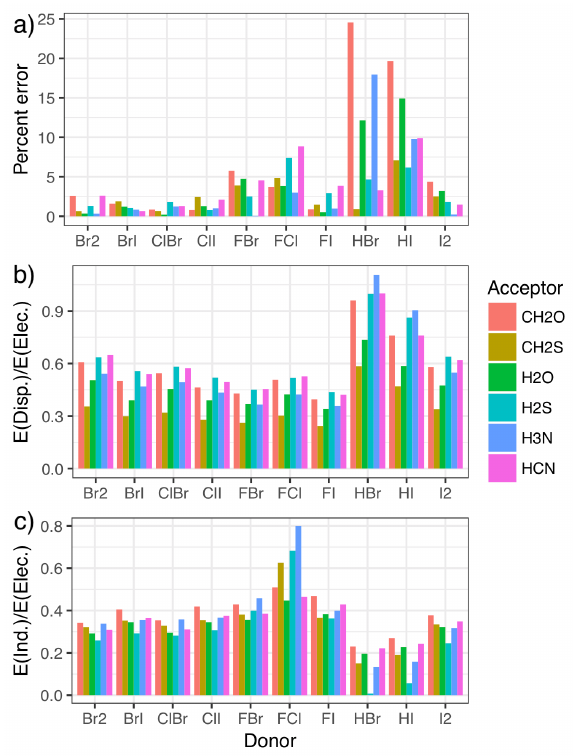
Figure 4. The error [relative to the CCSD(T)-F12b/CBS values] as a percentage of the overall interaction energy for the P 4 model ( a ) compared with the ratio of the dispersion ( b ) and induction ( c ) contributions to the electrostatic component of the symmetry-adapted perturbation theory of the